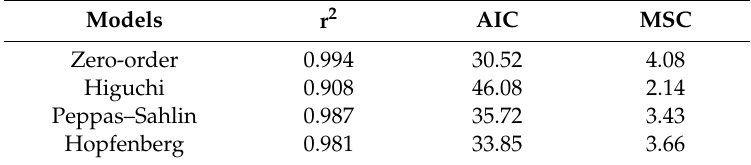
Table 3. Fitting results of the experimental GlcNAc release data to di ff erent kinetic